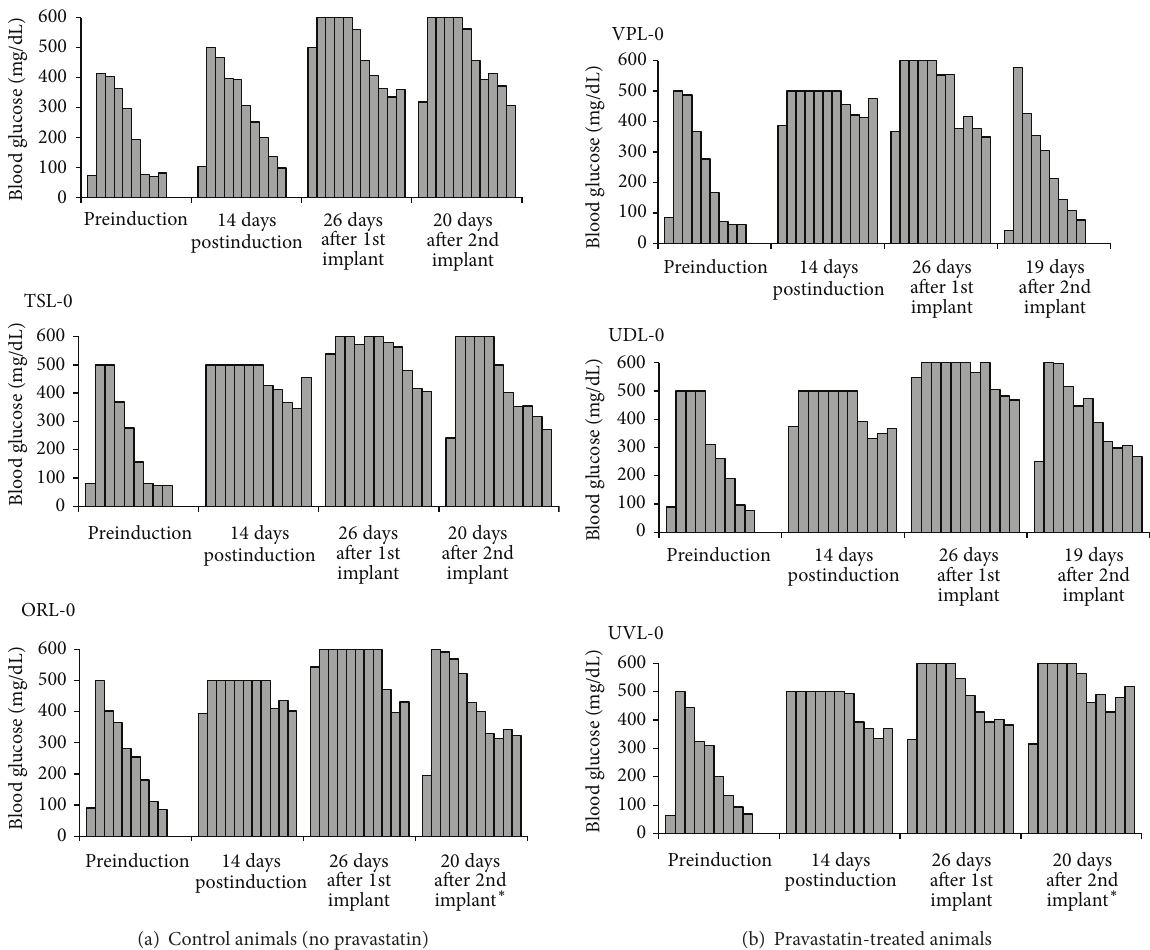
Figure 2: Blood glucose levels during IVGTTs at time = 2, 5, 10, 15, 30, 60, 90, 120, and 240 minutes following dextrose administration. Control animals (did not receive pravastatin) are shown in panel (a) (UYL-0, TSL-0, ORL-0). Macrobead recipients that received pravastatin are shown in panel (b) (VPL-0, UDL-0, UVL-0). ORL-0 and UVL-0 did not receive a second porcine islet macrobead